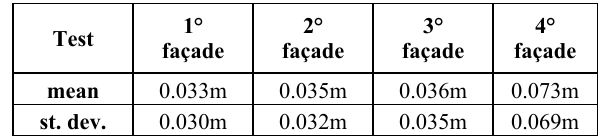
Table 3. The statistical parameters of the four analysed